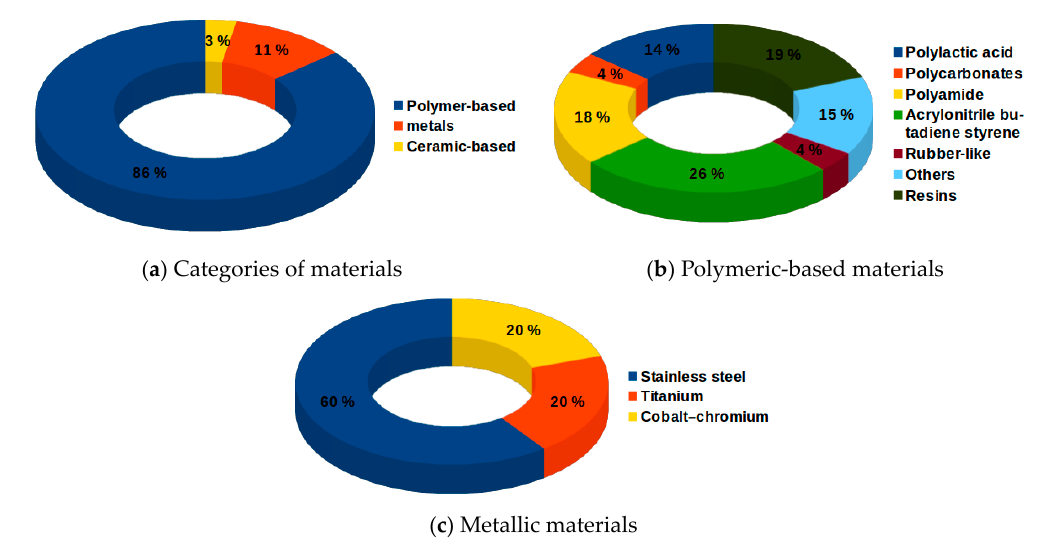
Figure 7. Classifications of materials used in printing medical devices.